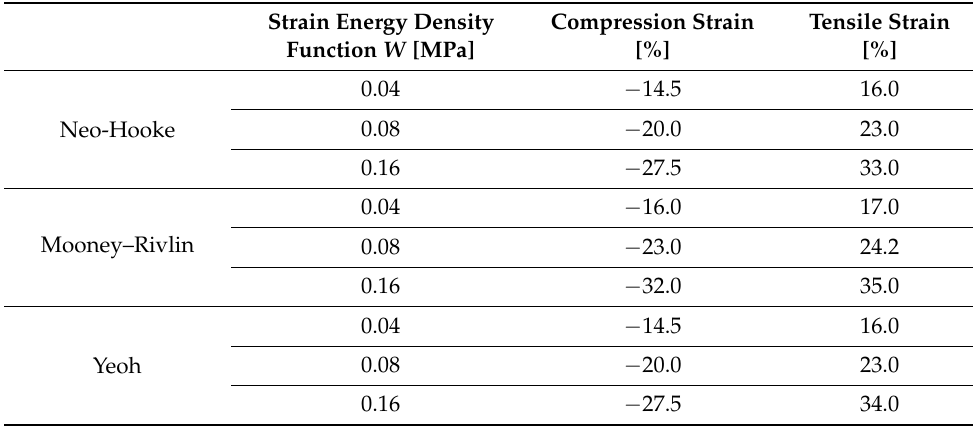
Table 4. Determination of the compression-equivalent strain of SBR measured in tensile mode from the strain energy density function W calculated using the neo-Hooke, Mooney–Rivlin and Yeoh models.